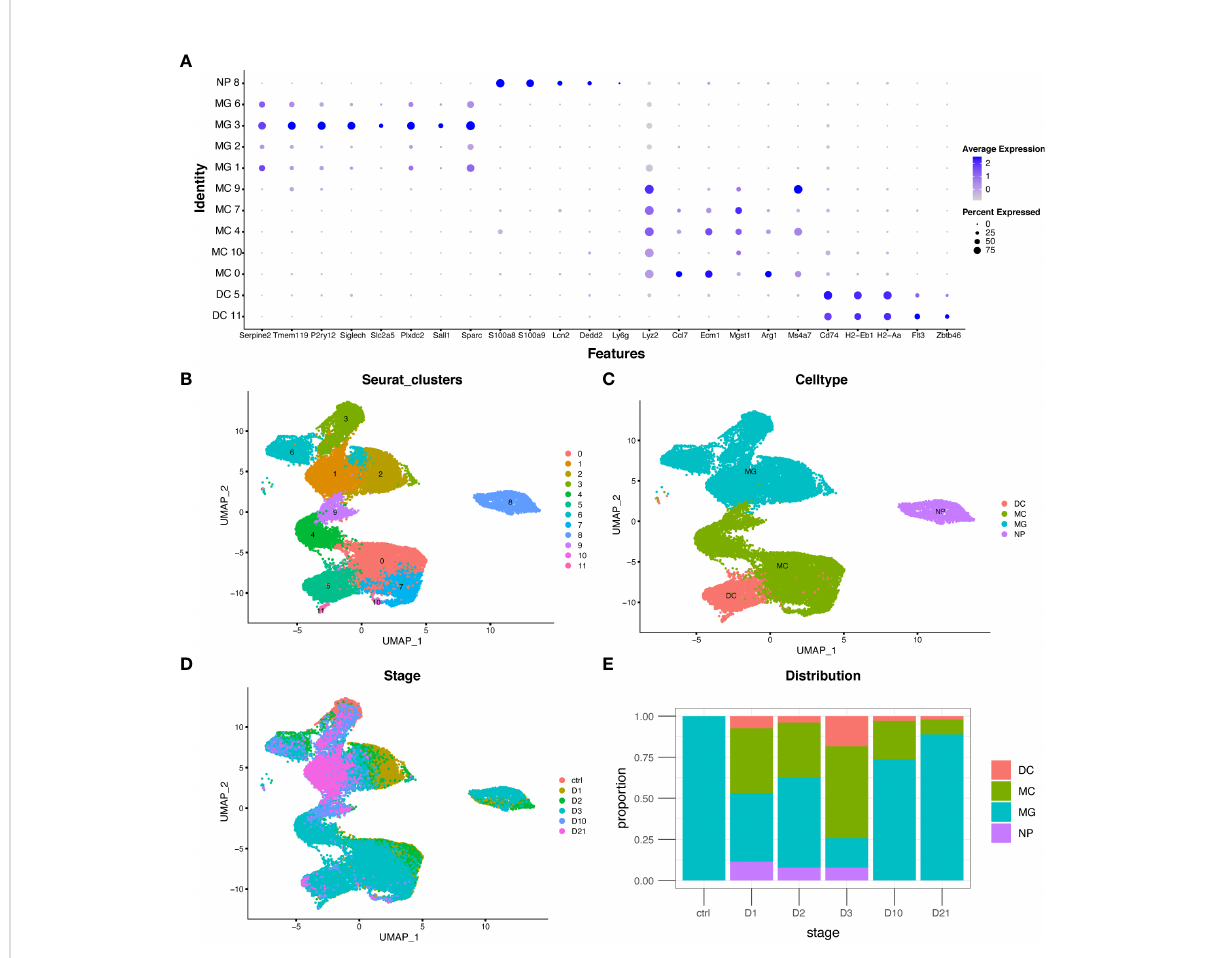
FIGURE 1 Distribution and proportion of myeloid cell subtypes following spinal cord injury (SCI). (A) Dot plot of marker genes in each population. (B – D) Uniform manifold approximation and projection (UMAP) plot of each population, four myeloid cell subtypes, and cells from different time points. (E) Bar graph showing the proportion of myeloid cell subtypes from different time points. DC, dendritic cells; MC, macrophages; MG, microglia; NP,